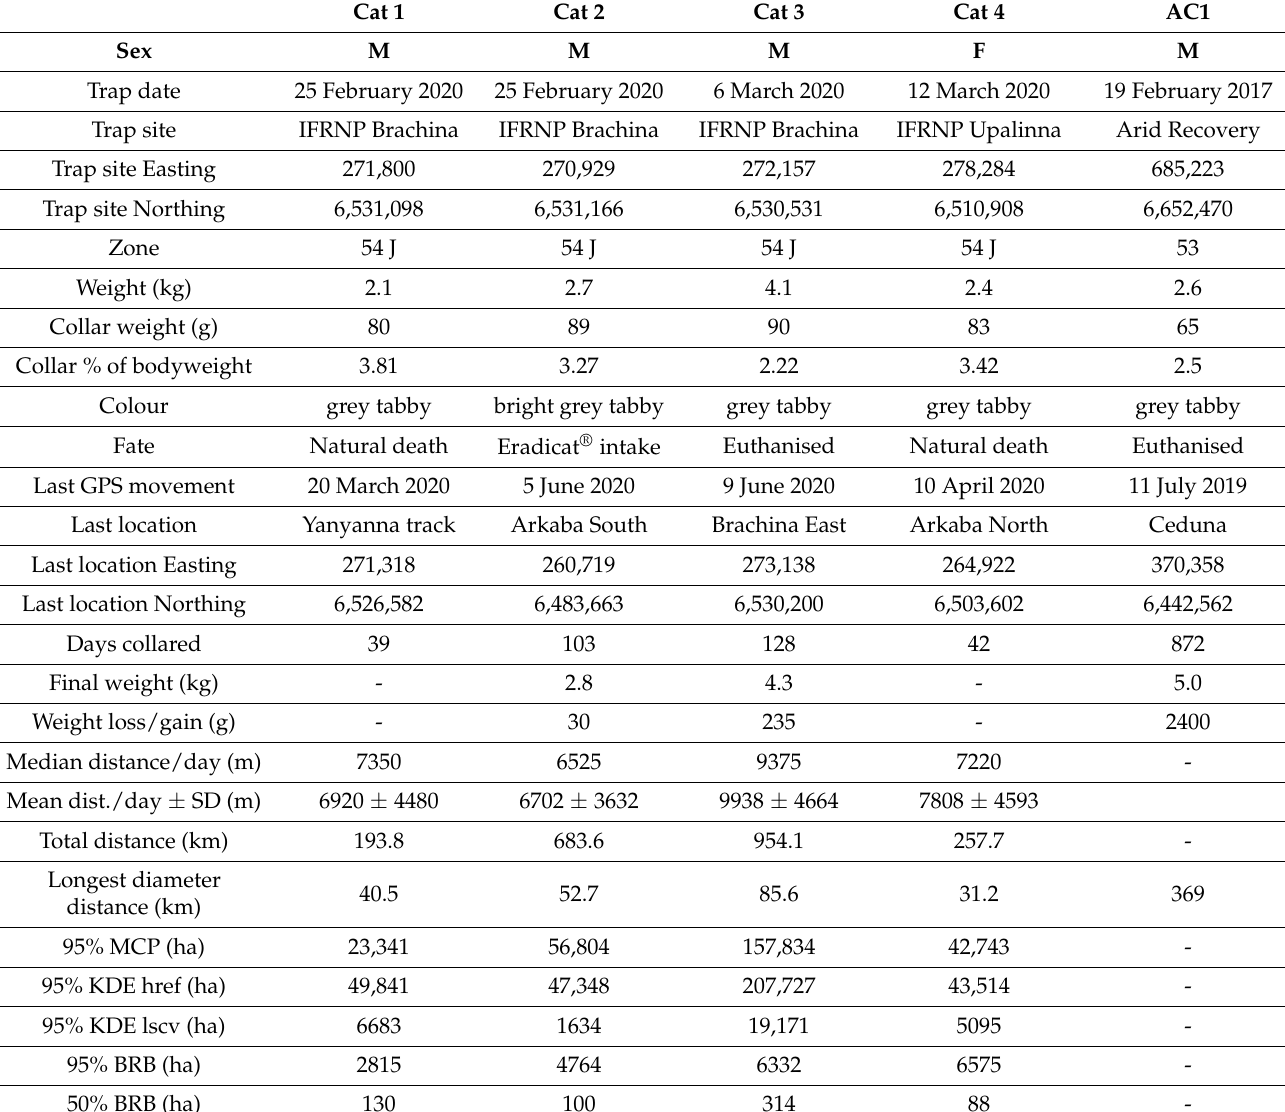
Table 1. Spatial, movement and fundamental metadata for the five GPS-collared feral cats that undertook long distance movements in semi-arid South Australia. Cats 1–4 were captured in the IFRNP, AC1 was captured at Arid